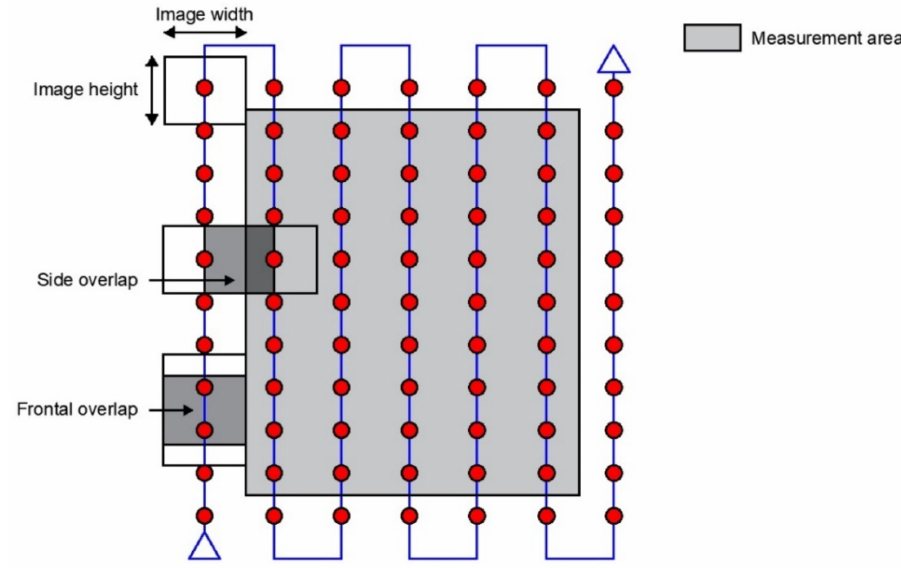
Figure 1. The graphic interpretation of the longitudinal and transverse coverage of